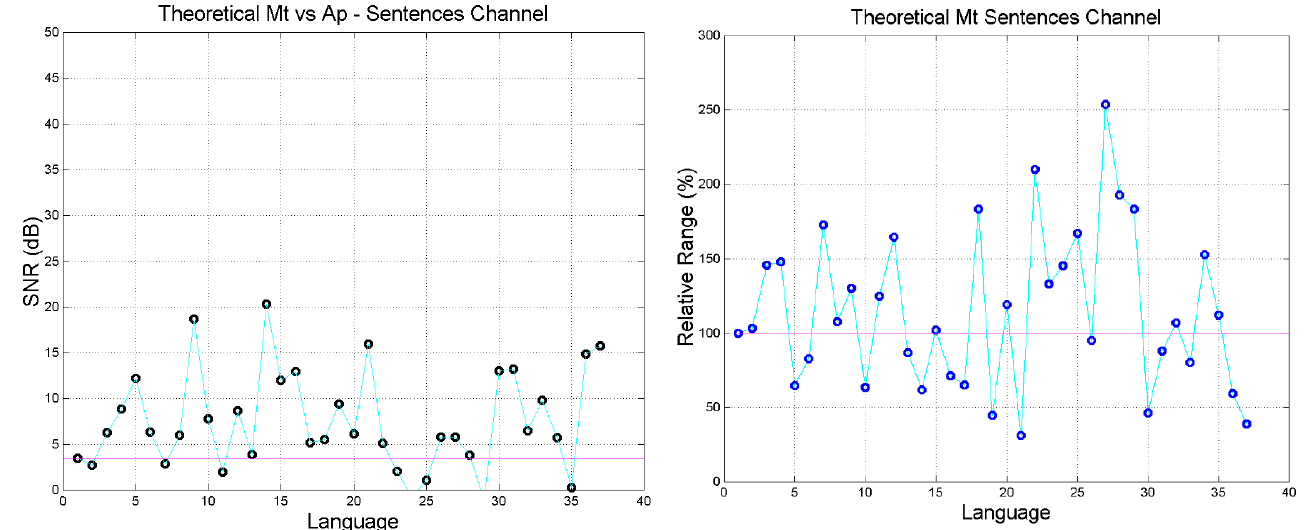
Figure 6. ( Left panel ): Sentences cross-channel theoretical signal-to-noise-ratio Γ dB in the indicated languages; Matthew versus Apocalypse. Languages are ordered according to Table 1. ( Right panel ): Sentences channel relative range (%) in the indicated languages. The magenta line corresponds to Greek (language no.1).